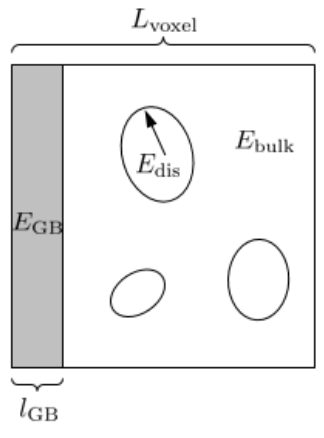
Figure 6. Illustration of grain boundary and dislocation volume voxel